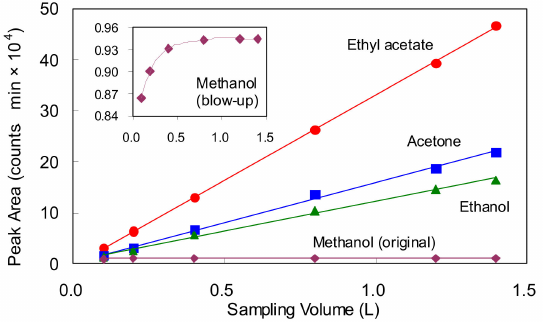
Figure 6. The sampling capacity test of µ -preconcentrator for highly volatile compounds. All compounds are at the 100 ppb level. The sampling flow rate was 40 mL/min. The corresponding peak areas were measured after sampling for various volumes and then desorbed into